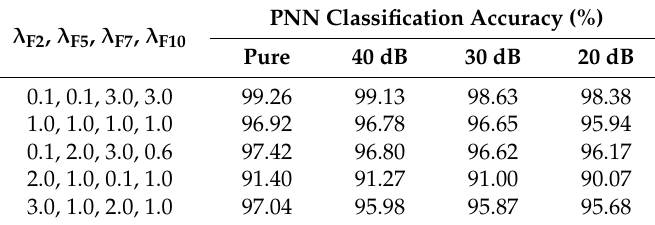
Table 3. PNN classification accuracy with noise